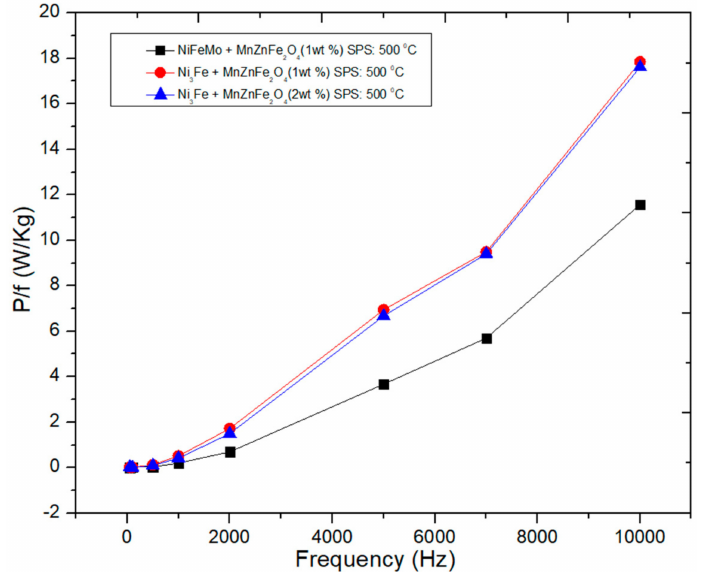
Figure 15. Evolution of the power losses as a function of the frequency for toroidal-shaped (Ni 3 Fe, supermalloy)/Mn 0.5 Zn 0.5 Fe 2 O 4 composite compacts, SPS-ed at the sintering temperature of 500 ◦ C. The induction level was set at 0.01